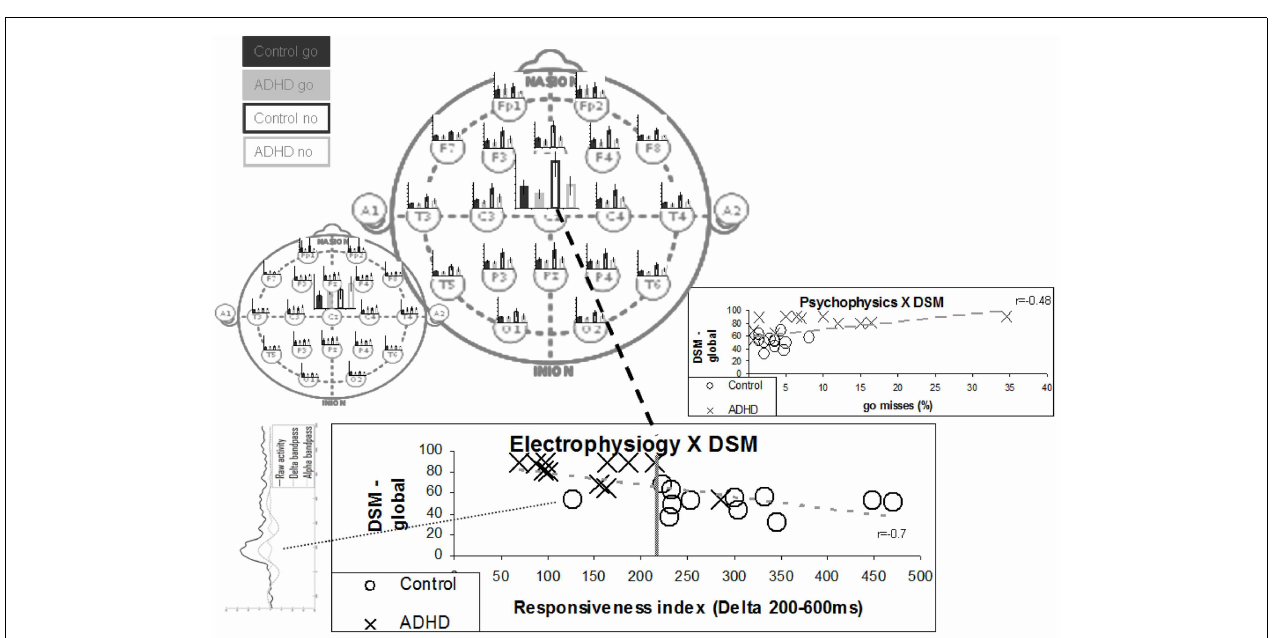
topographic image to emphasize the differences between the two distributions. Note that the separation between groups is better than the one obtained for the best psychophysical index – presented in the inset on the right (also correlation with DSM is stronger). Note that one ADHD subject actually shows both electrophysiological and DSM characteristics more similar to control subjects. Note that the one deviant subject has ERP activity which does not involve clear N1, N2, and P2 activities (bottom left